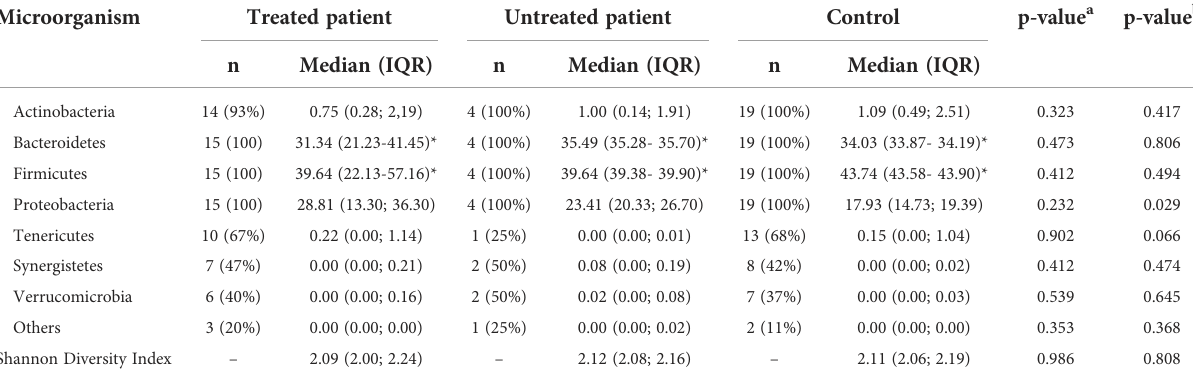
TABLE 2 Microbial phyla and a -diversity (Shannon diversity index) in the fecal microbiota of patients and controls in this study.